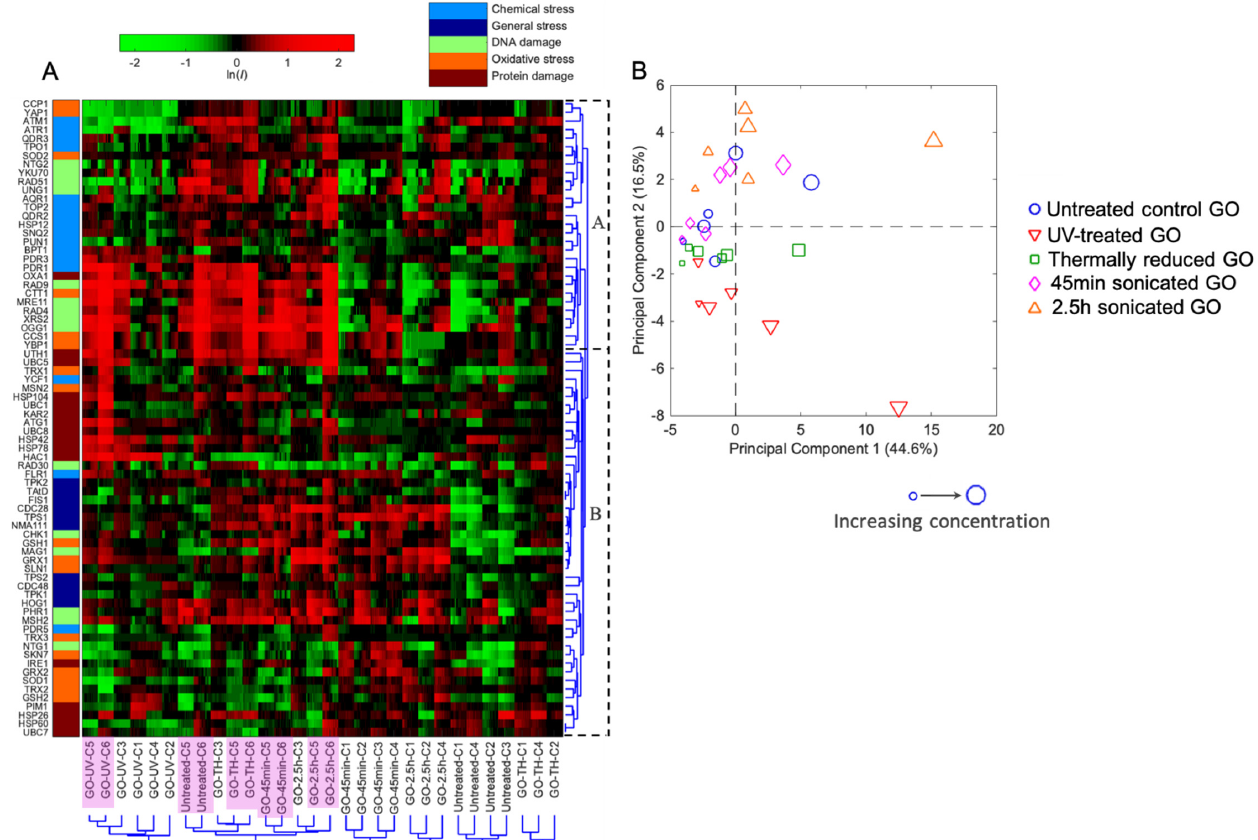
Figure 2. ( A ) Hierarchical cluster (HCL) analysis diagram on the basis of differential protein expressions (ln I , average of triplicates) of the 74 stress biomarkers in yeast in response to the five studied graphene oxides (GOs). The mean natural log of positive induction factors (ln I ) indicates the magnitude of regulated protein expressions (scaled by the green-black-red color spectrum at the top. Green color spectrum indicates downregulation, and red color spectrum indicates upregulation. The ln I values beyond ± 2 are indicated as ± 2). x -axis bottom: sample names and concentrations of the GOs. C1-C6 indicate concentrations 1-6, which are 0.031, 0.125, 0.5, 2, 8 and 32 mg/L, respectively. Higher concentrations C5 and C6 are in purple background. y -axis left : list of proteins categorized within five stress categories (captions shown at top). y -axis right : cluster root of protein markers and subclusters. ( B ) Principal component analysis (PCA) with differential protein expressions (ln I , average of triplicates) in a GFP-fused yeast library exposed to the 5 GOs across 6 concentrations. Samples are color-coded and each legend shape indicates one treatment with a larger legend size representing the higher